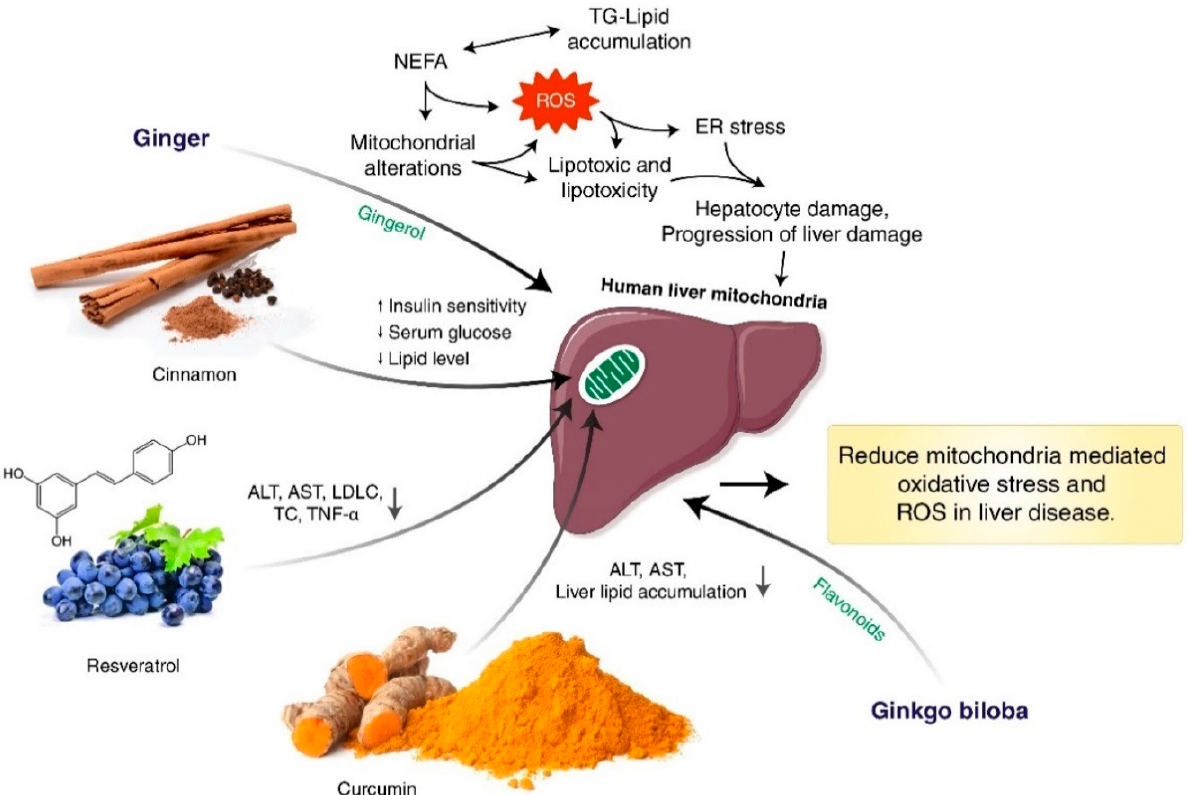
Figure 5. Effects of herbal compounds to reduce mitochondria-mediated oxidative stress and ROS in liver disease. Alanine amino transferase (ALT), and high density amino transferase (AST), non- esterified fatty acids (NEFA), low-density lipoprotein cholesterol (LDLC), total cholesterol (TC), tumor necrosis factor alpha (TNF- α ). The accumulation of TG and NEFA induces mitochondrial deformation and ROS, resulting in liver and hepatocyte damage caused to lipotoxicity and ER stress. Cinnamon improves insulin sensitivity, decreasing lipid and blood glucose. Low-density lipoprotein cholesterol (LDLC), total cholesterol (TC), and TNF- α decreased by resveratrol. Curcumin reduced AST and ALT levels and liver lipid storage. ↑ , up-regulation; ↓ , down-regulation.